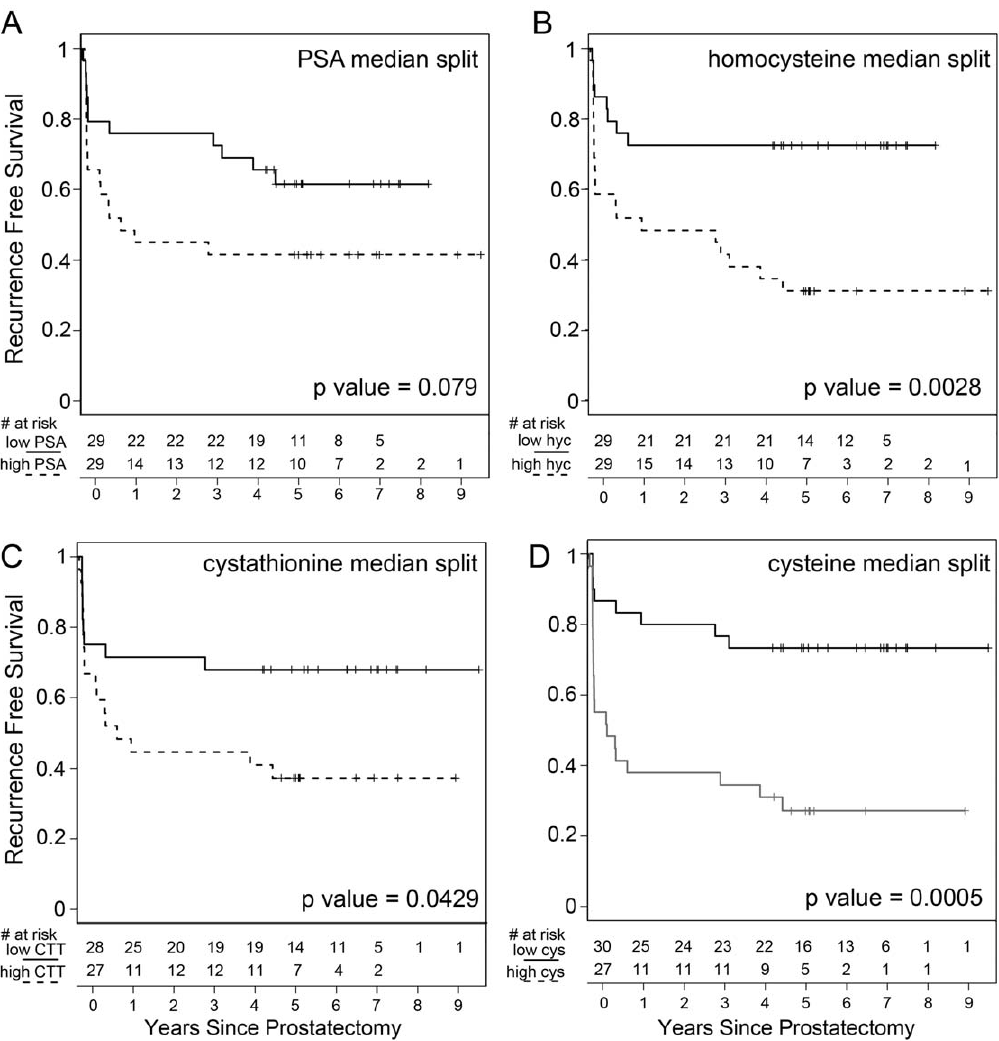
Figure 1. Kaplan-Meier plots indicate univariate predictive values of the recurrence-free survival based on pre-surgical serum. The patients were separated into two groups, divided at median tissue level for (A) PSA, (B) homocysteine, (C) cystathionine, and (D) cysteine as significantly associated with time to recurrence (Table 5). Those subjects above the median expression level were termed upper half, whereas those below the median were termed lower half. The recurrence-free survival probabilities were estimated by the Kaplan-Meier method and the differences were tested using the log-rank test. Each of the dichotomous serum markers supported statistically significant differences in biochemical recurrence- free survival.